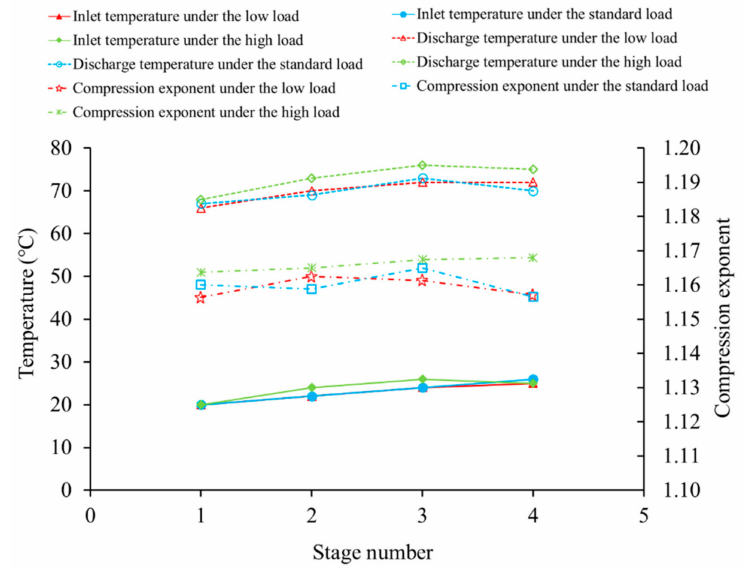
Figure 21. Comparison of the temperatures and compression exponent between di ff erent load